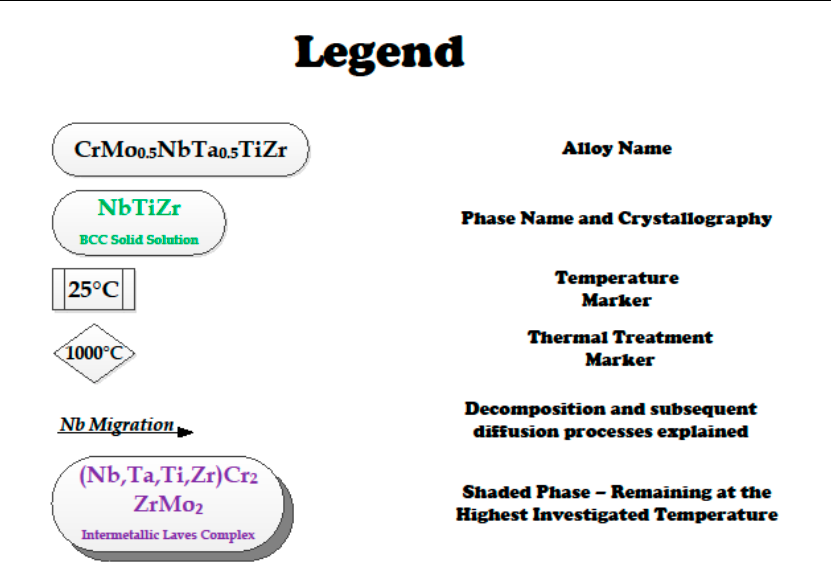
Figure 11 . Legend for the flowcharts in Figures 9 and 10. Figure 11. Legend for the flowcharts in Figures 9 and